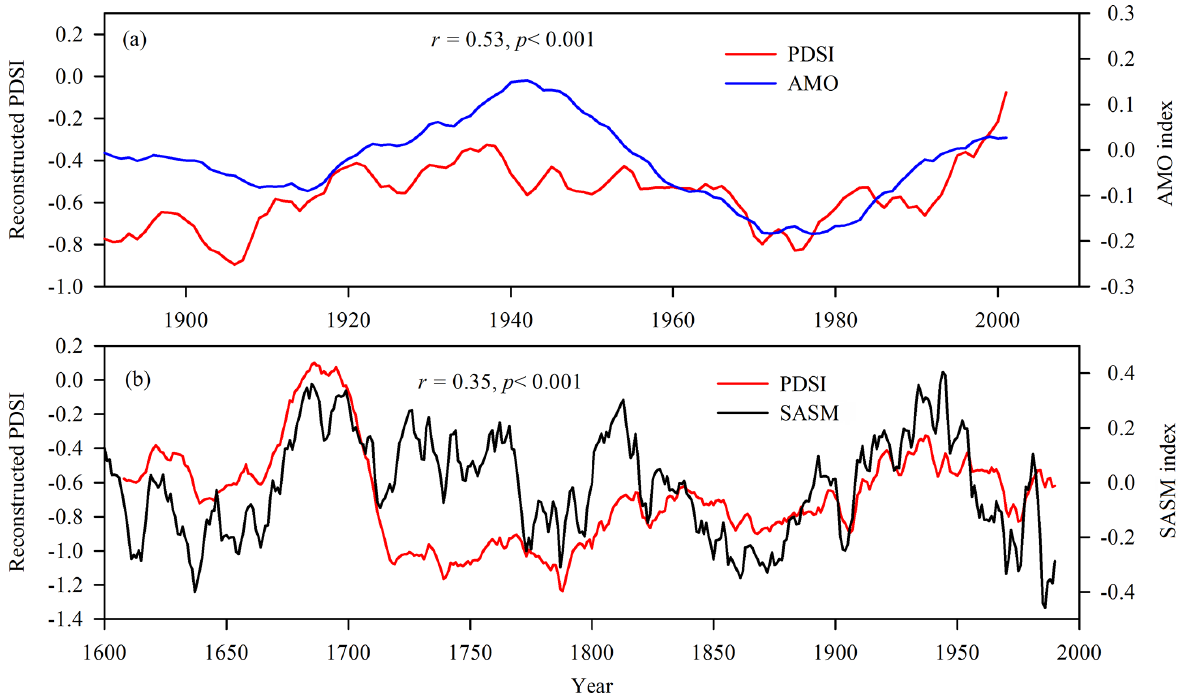
Figure 9. (a) Comparison of the 31-year moving average series between the reconstructed Mar–Aug scPDSI and the AMO index during the common period (1890–2001; van Oldenborgh et al., 2009); (b) comparison of the 31-year moving average series between the reconstructed Mar–Aug scPDSI and the South Asian summer monsoon index from June to August (JJA, SASM) (Cook et al., 2010) during the common period